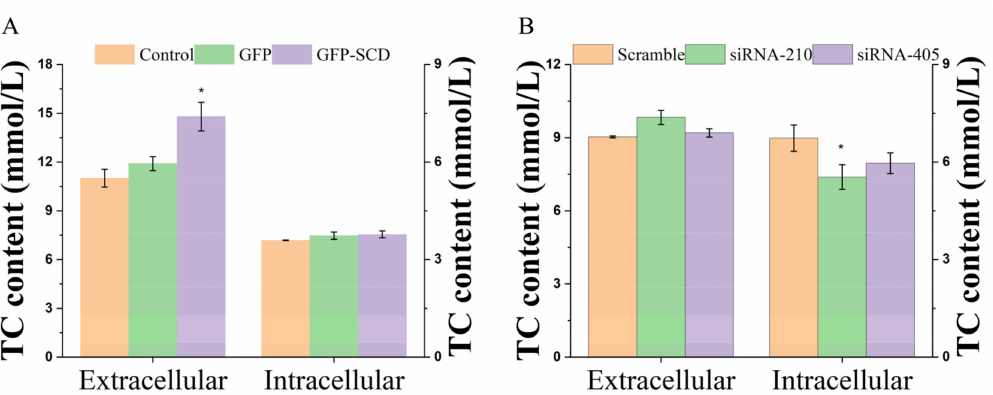
Figure 2. Changes in intracellular and extracellular total cholesterol (TC) content after transfec- tion (Unit: mmol/L). ( A ) Overexpression-transfected group. ( B ) Small interfering RNA (siRNA)- transfected group. Asterisks indicate a significant intracellular or extracellular difference between groups ( p <